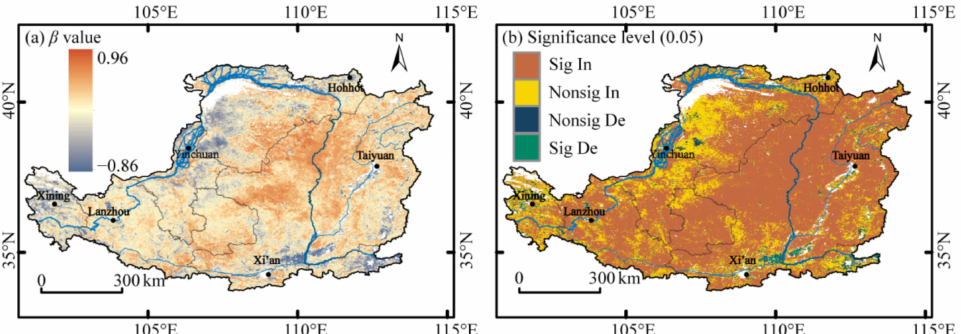
Figure 5. Trend and significance of the growing-season WVCI in the Loess Plateau from 2001 to 2019. ( a ) Growing-season WVCI trend; ( b ) significance of growing-season WVCI trend. ‘Sig In’, ‘Nonsig In’, ‘Sig De’ and ‘Nonsig De’ are abbreviations for ‘significant increase’, ‘non-significant increase’, ‘significant decrease’ and ‘non-significant decrease’,